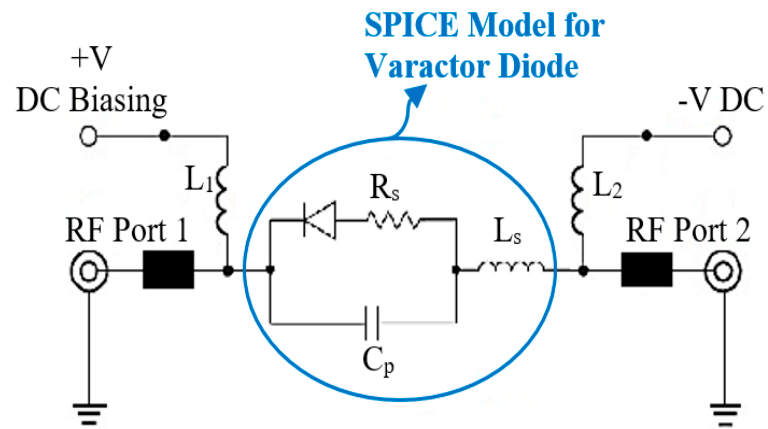
Figure 10. RF and DC biasing circuit for the presented reconfigurable filter.